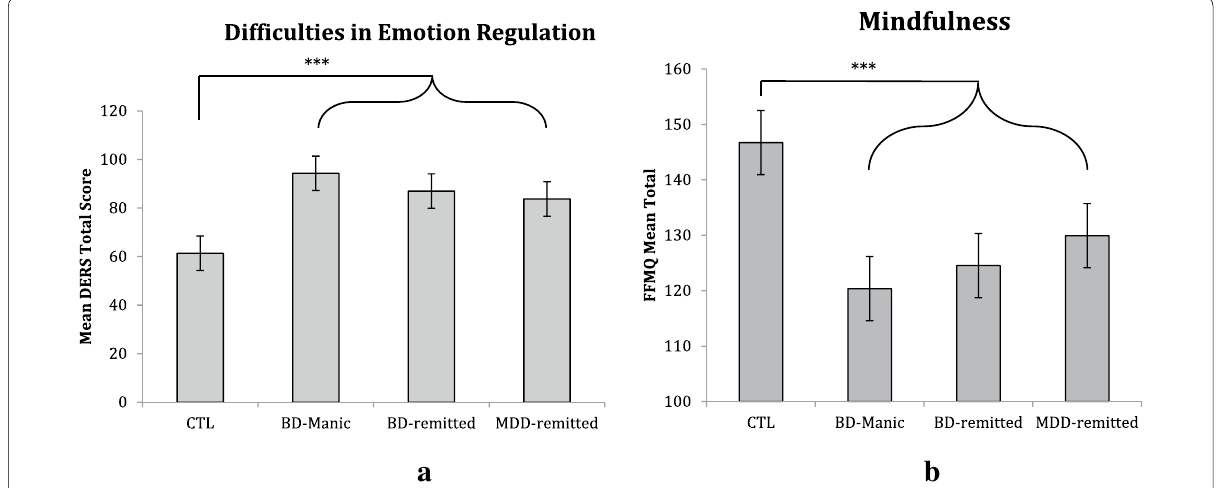
Fig. 1 Group differences in total scores for difficulties in emotion regulation ( a ) and mindfulness-based regulation strategies ( b ) . Error bars represent standard errors of the mean. * p < .05, ** p < .01, *** p <